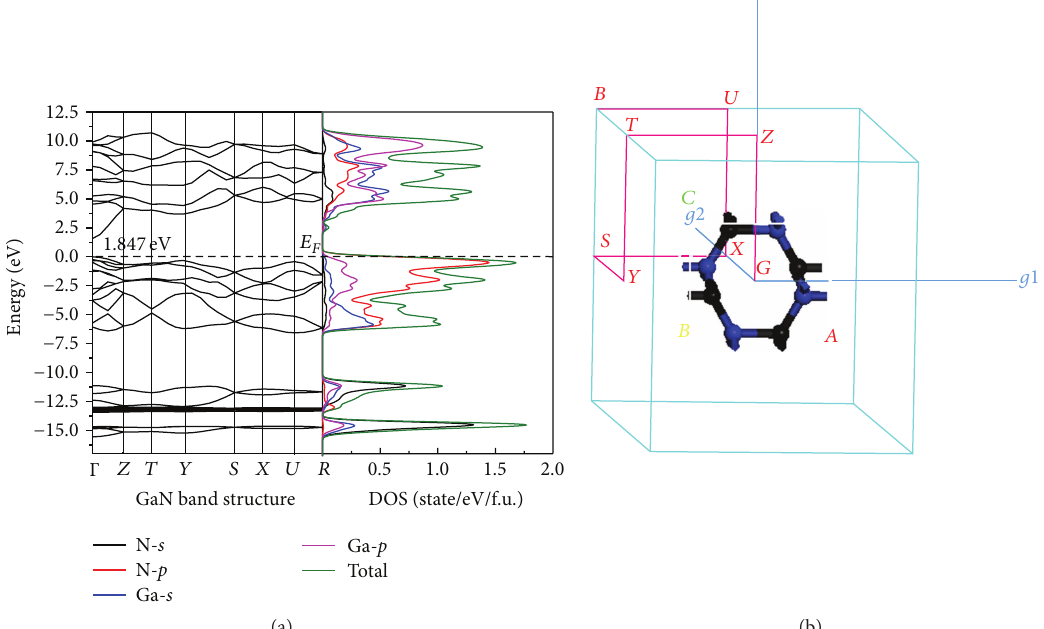
Figure 4: Electronic band structure and density of state (a) for the Pnma-GaN at ambient pressure and Brillouin zone of Pnma-GaN (b).